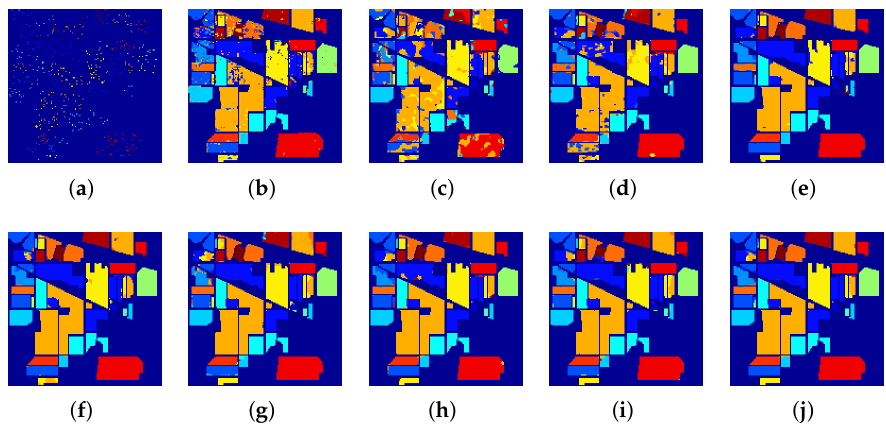
Figure 8. Classification maps for the IN dataset with 525 labeled training samples: ( a ) training samples ( b ) SVM (EMAPs) ( c ) HS-GAN ( d ) 3D-GAN ( e ) SS-GAN ( f ) AD-GAN ( g ) F 2 -Concat. ( h ) F 2